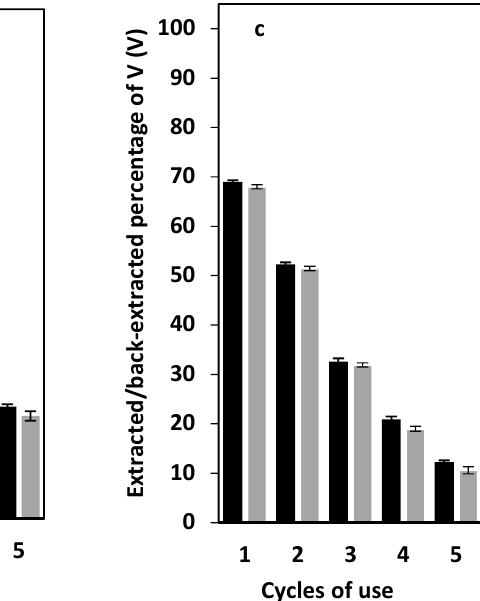
Figure 9. Extraction (black bars)/back-extraction (grey bars) percentage of V(V) in the case of PIMs containing ( a ) 50/40/10 wt% of PVDF-HFP/Aliquat ® 336/DBP, ( b ) 50/40/10 wt% of PVDF-HFP/Aliquat ® 336/NPOE, or ( c ) 49/40/10/1 wt% of PVDF-HFP/Aliquat ® 336/DBP/rGONPs. Experimental conditions: aqueous source solution 50 mL of 50 mg L −1 V(V) and 0.2 mol L −1 sulfate ion (pH 2.5), back-extraction solution 50 mL of 6 mol L −1 H 2 SO 4 and 1 V/V% H 2 O 2 . PIMs/aqueous solutions shaking time in both the extraction and back-extraction processes 24 h.